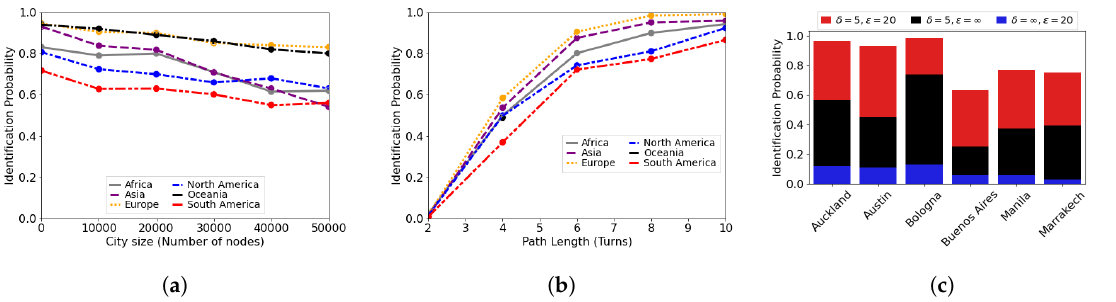
Figure 6. ( a ) shows the Identification probability for increasingly large cities. ( b ) shows the same metric, plotted instead against the path length. Finally ( c ) shows the comparison when considering only the accelerometer, only the magnetometer, or